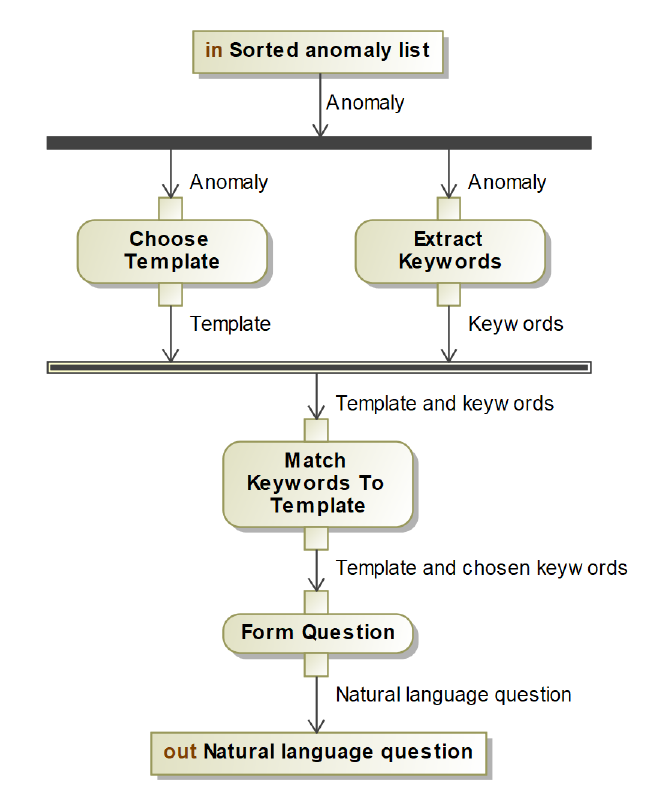
Figure 8. Forming a natural language